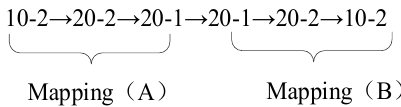
Figure 7. The vector synthesizing sequence of dual-pulse mapping strategy.